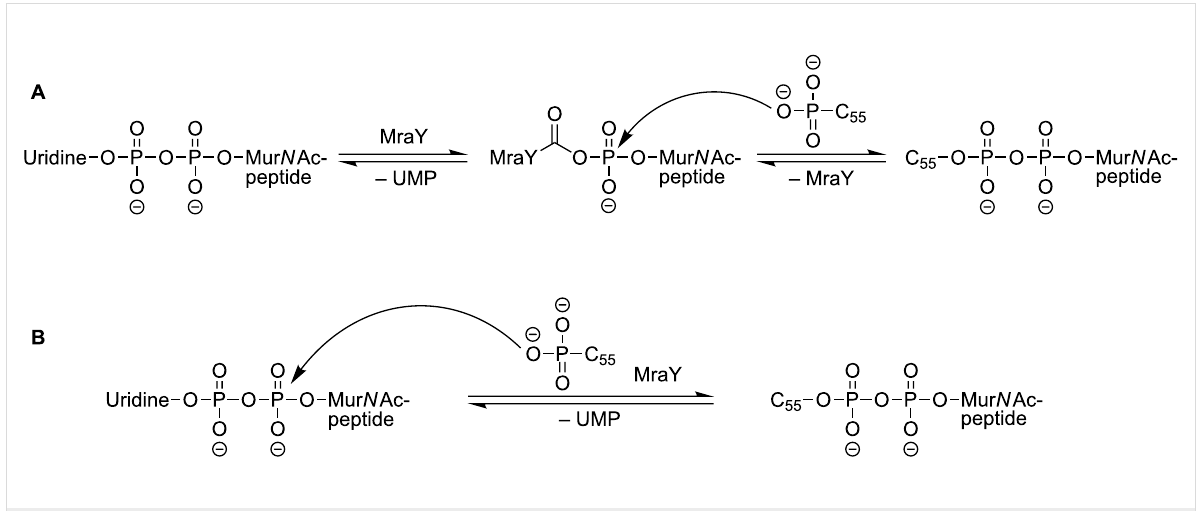
Figure 6: Proposed mechanisms for the MraY-catalysed reaction. A: Two-step mechanism postulated by Heydanek et al. [66]; B: one-step mecha- nism postulated by Bouhss et al. [69].